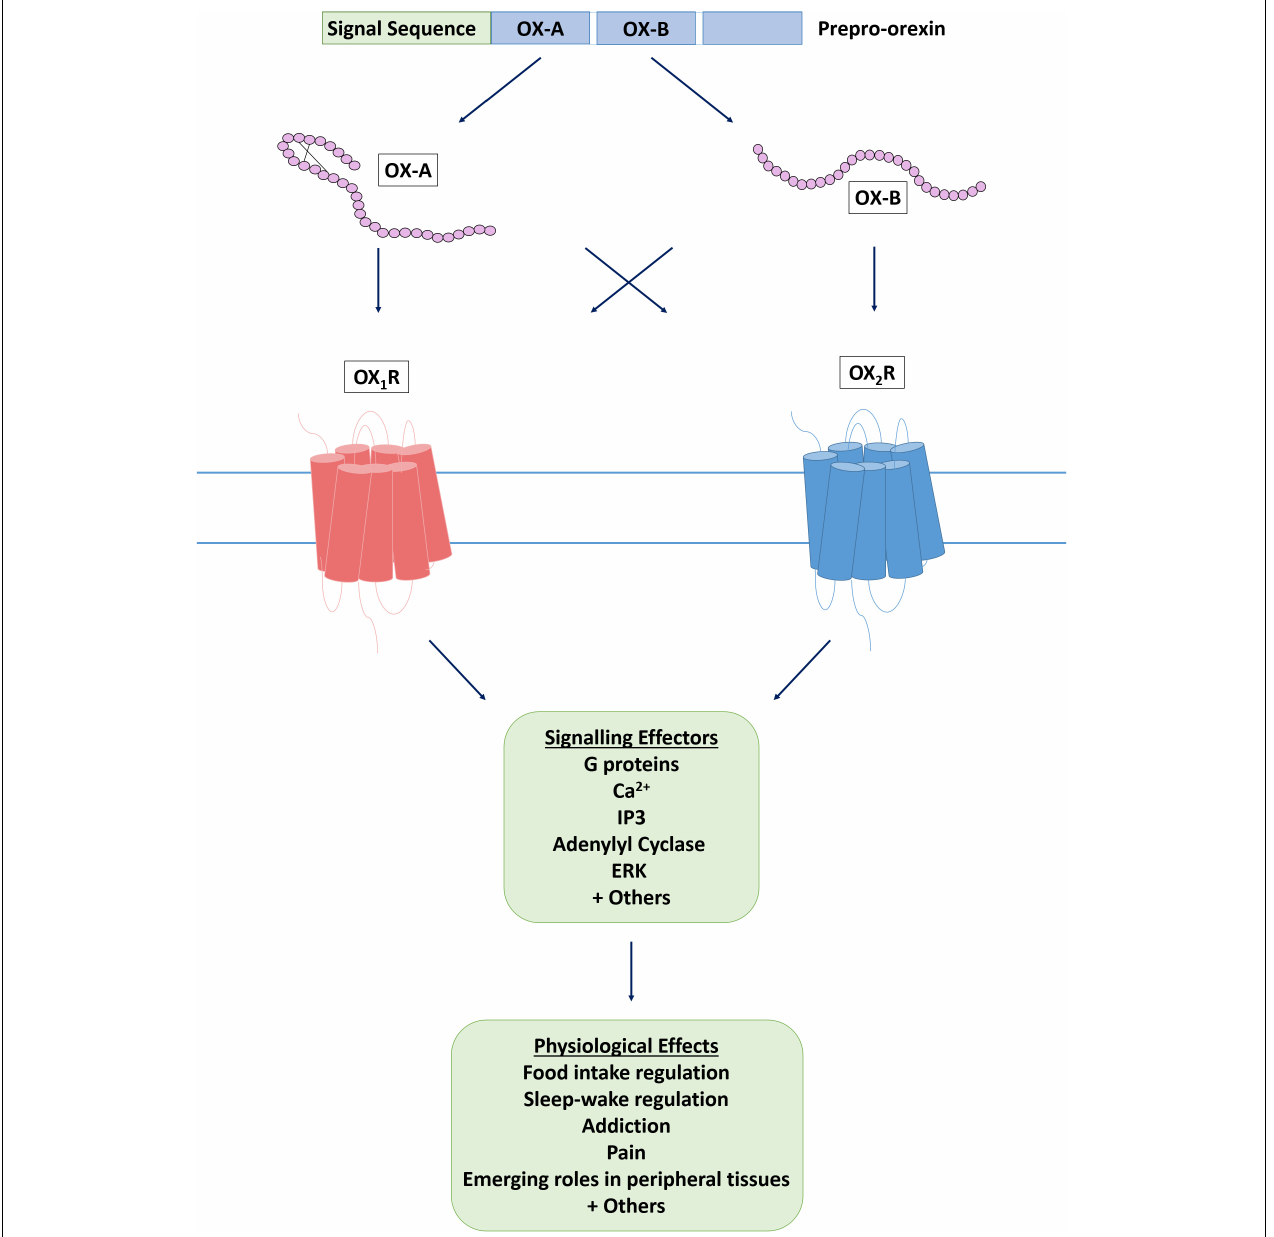
FIGURE 1 | The orexin system. The orexin system consists of two endogenous peptide agonists, OX-A and OX-B, cleaved from the common precursor peptide prepro-orexin. Both agonists have affinity for the two orexin receptors, OX 1 R and OX 2 R, although it has been suggested that OX-B has some OX 2 R selectivity, whereas OX-A is not selective. Following agonist binding, an active conformation of the receptor is stabilized and effector proteins are recruited to induce a cellular